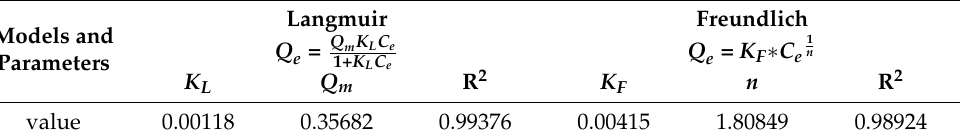
Table 3. Fitting the parameters of the Langmuir and Freundlich equations to the PANI-OH-3 adsorbents. Models and